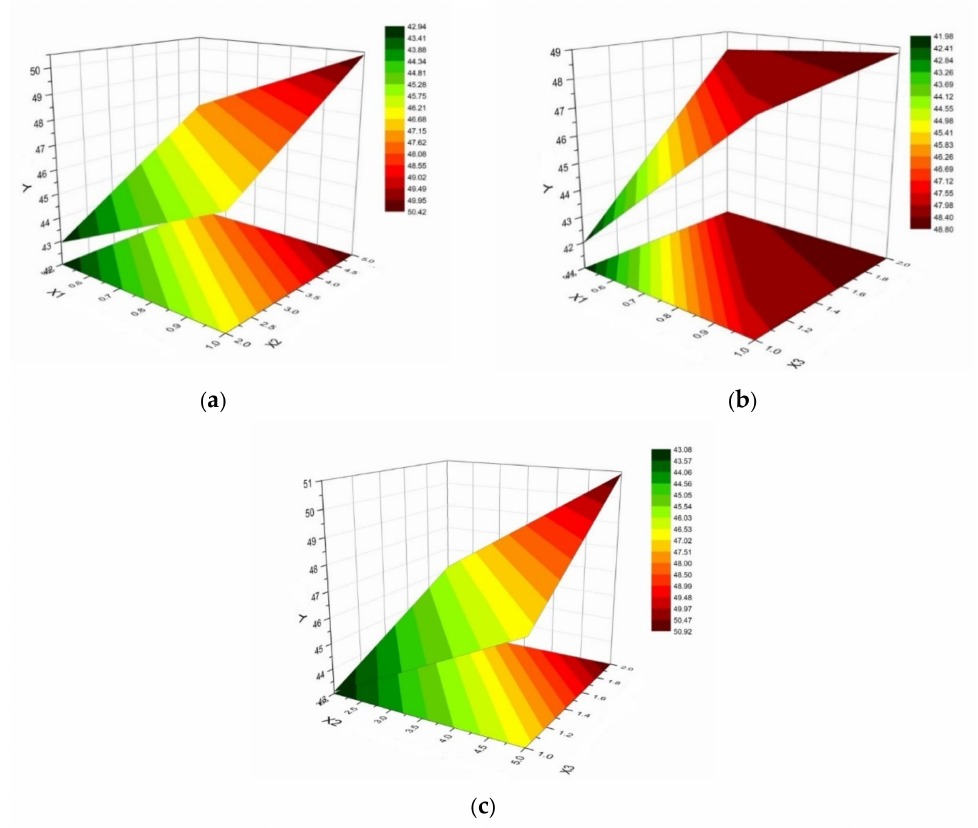
Figure 8. Highlighting in 3D the evolution of the Y (CA ( ◦ )) response parameter as a function of the formulation variables ( a ) X 1 (chitosan concentration) and X 2 (HPMC E 5 LV concentration); ( b ) X 1 (chitosan concentration) and X 3 (chitosan/HPMC E 5 LV ratio); and ( c ) X 2 (HPMC E 5 LV concentration) and X 3 (chitosan/HPMC E 5 LV